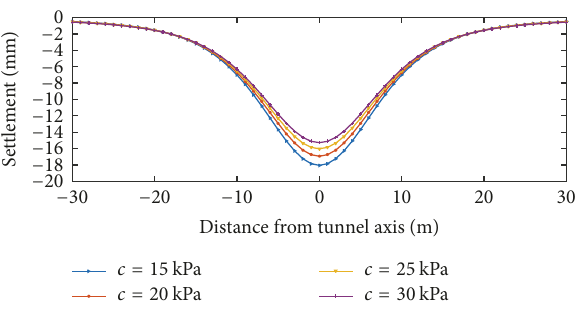
Figure 6: Influence of 𝑐 on surface settlement.